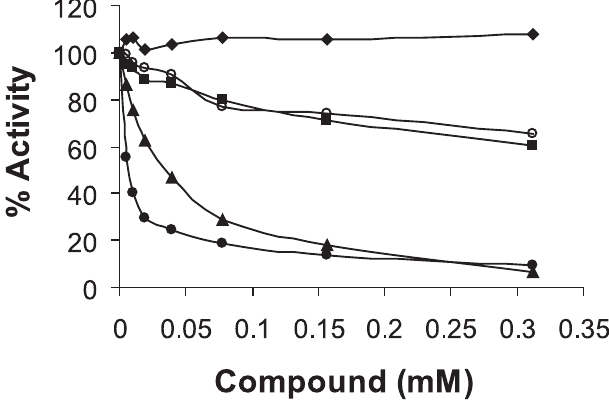
Figure 5 Inhibitory Effect of Isoprenaline, PLP, Quercetin, DBHD, and PCP on Sulfotransferase Activity of SULT1B1 with 1-Naphthol as Substrate Sulfotransferase activity of SULT1B1 at different concentrations of each compound (5 to 312 l M) has been assayed as described in Materials and Methods. Isoprenaline is indicated by a filled diamond, PLP by an open circle, quercetin by a filled square, DBHD by a filled triangle, and PCP by a filled circle.